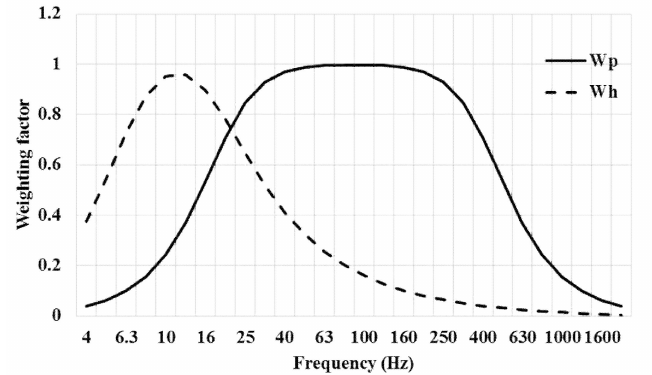
Figure 13. The weighting curves W h and W p